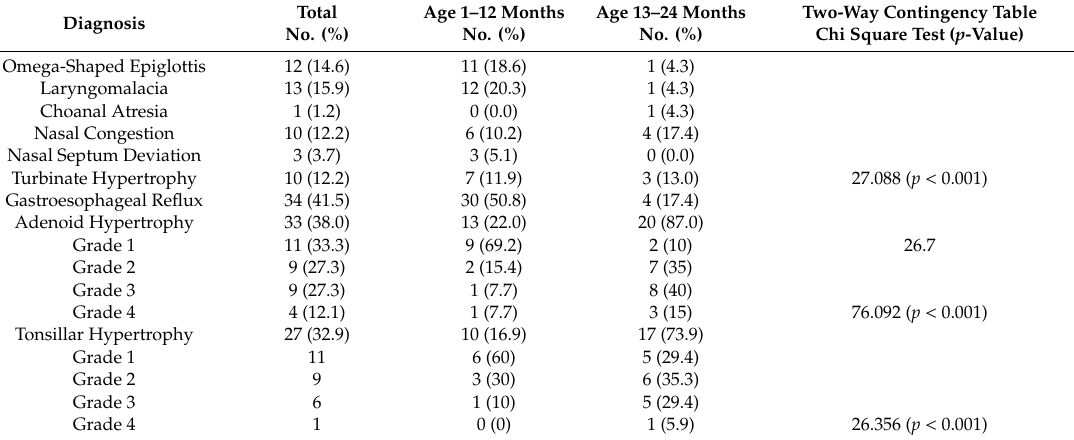
Table 3. Diagnostic findings of otorhinolaryngology and